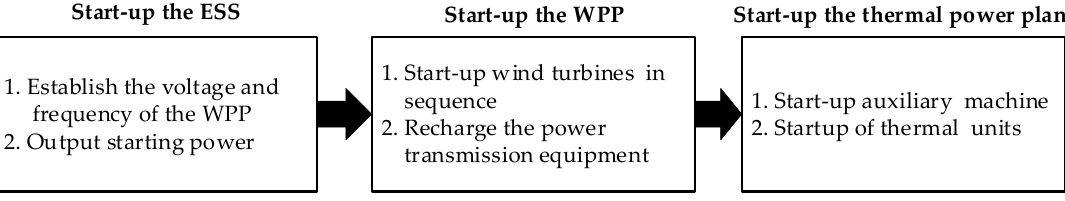
Figure 1. Black-start process based on the wind power plant (WPP) with energy storage system (ESS).